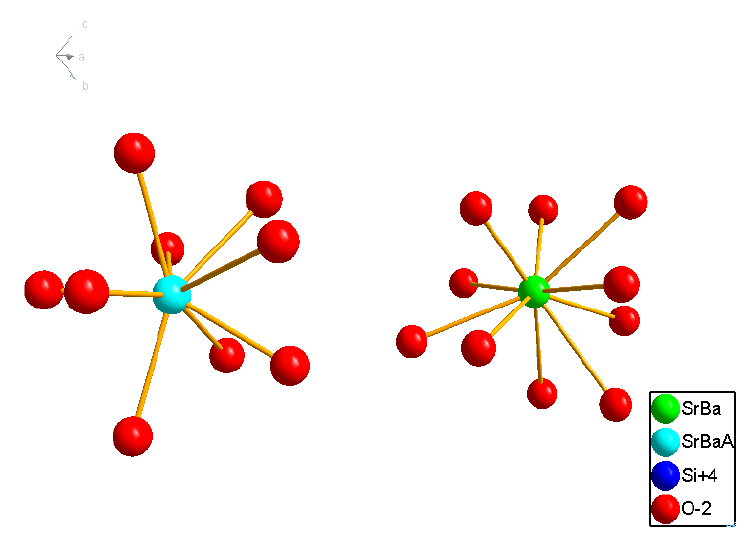
Ba )SiO crystal 1.9 0.1 4